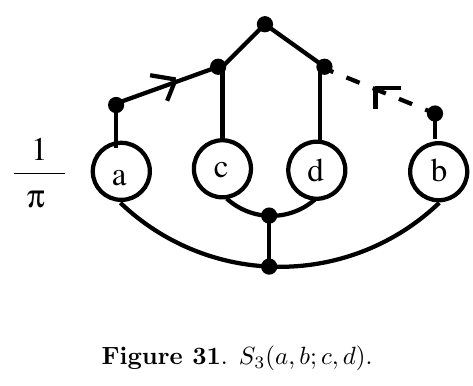
Figure 31 . S 3 ( a; b ; c; d ).